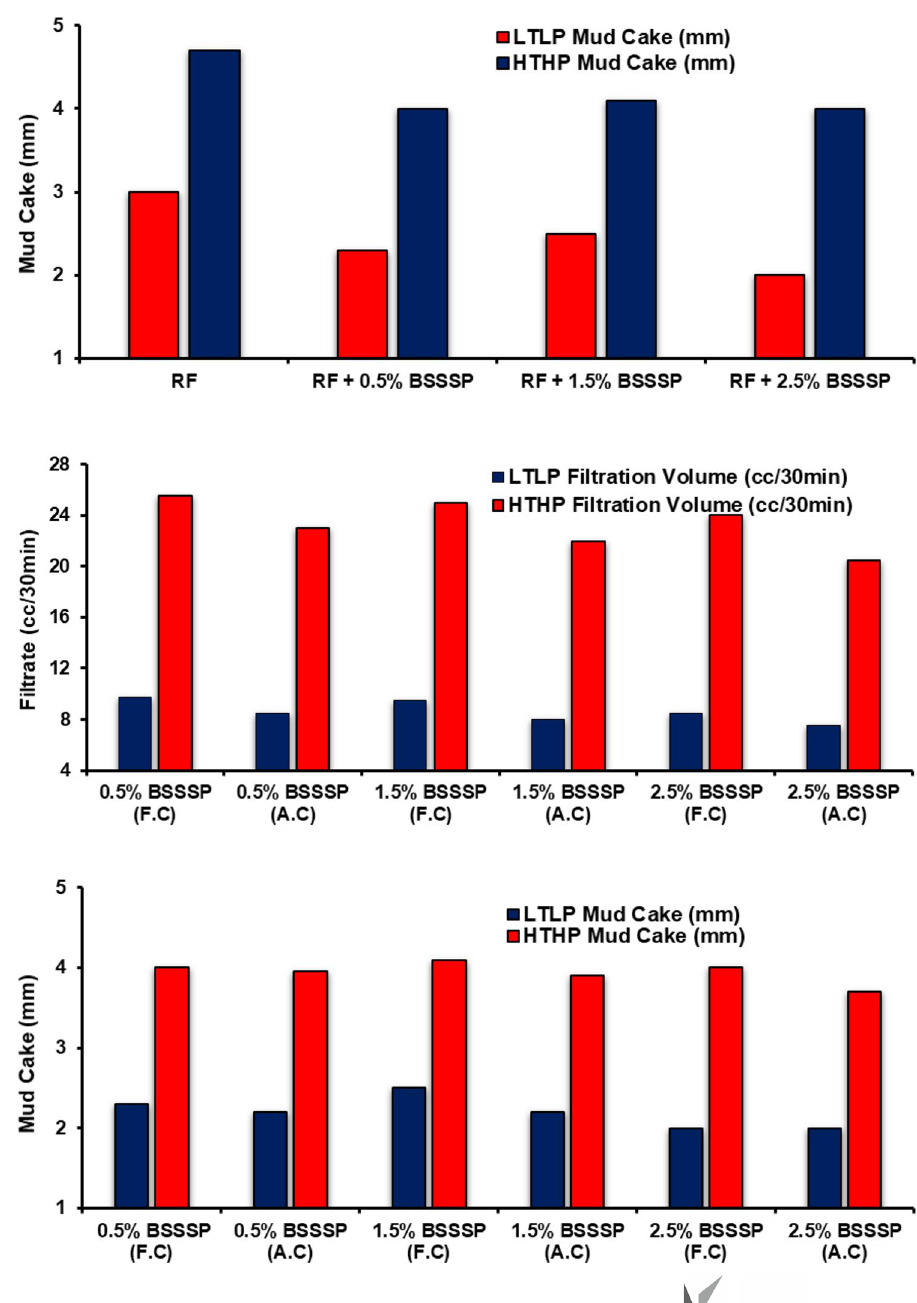
Fig. 9 Effect of BSSSP on the filter cake (fresh conditions; LTLP and HTHP conditions)